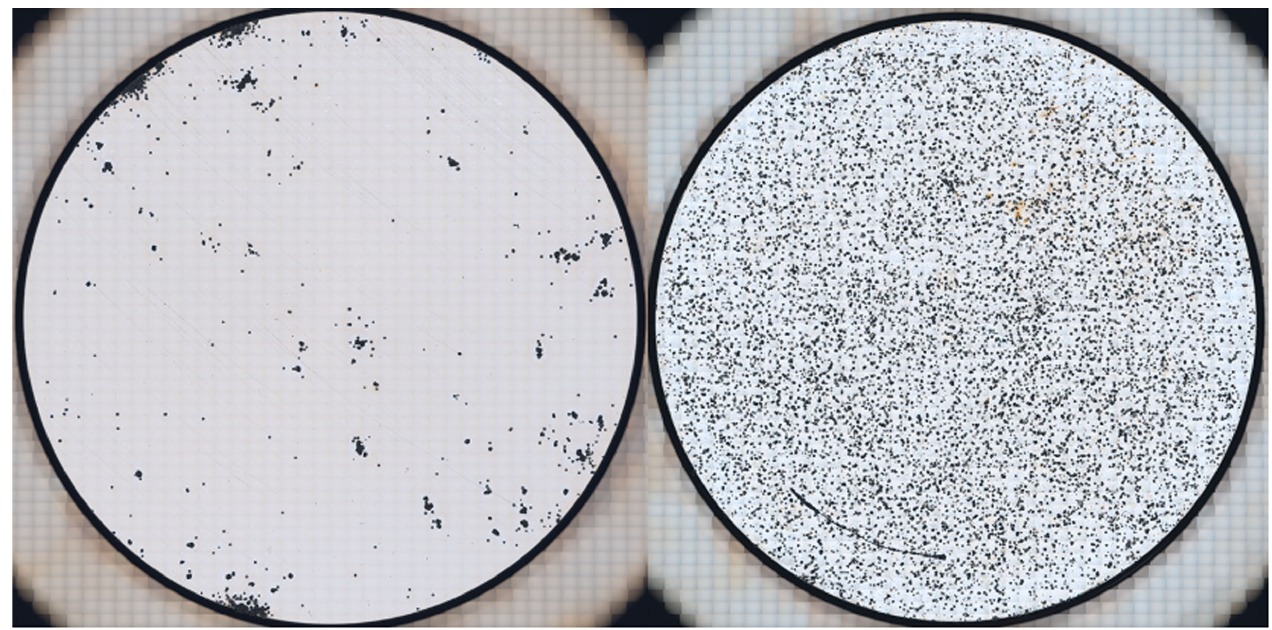
FIG. 4. Micrographs obtained by a scanning optical microscope of a hard electrode (sample 4, left image) and a soft electrode (sample 5, right image). Illumination of the samples provides a sharp contrast between the smooth undisturbed surface (white) and the areas damaged by breakdown